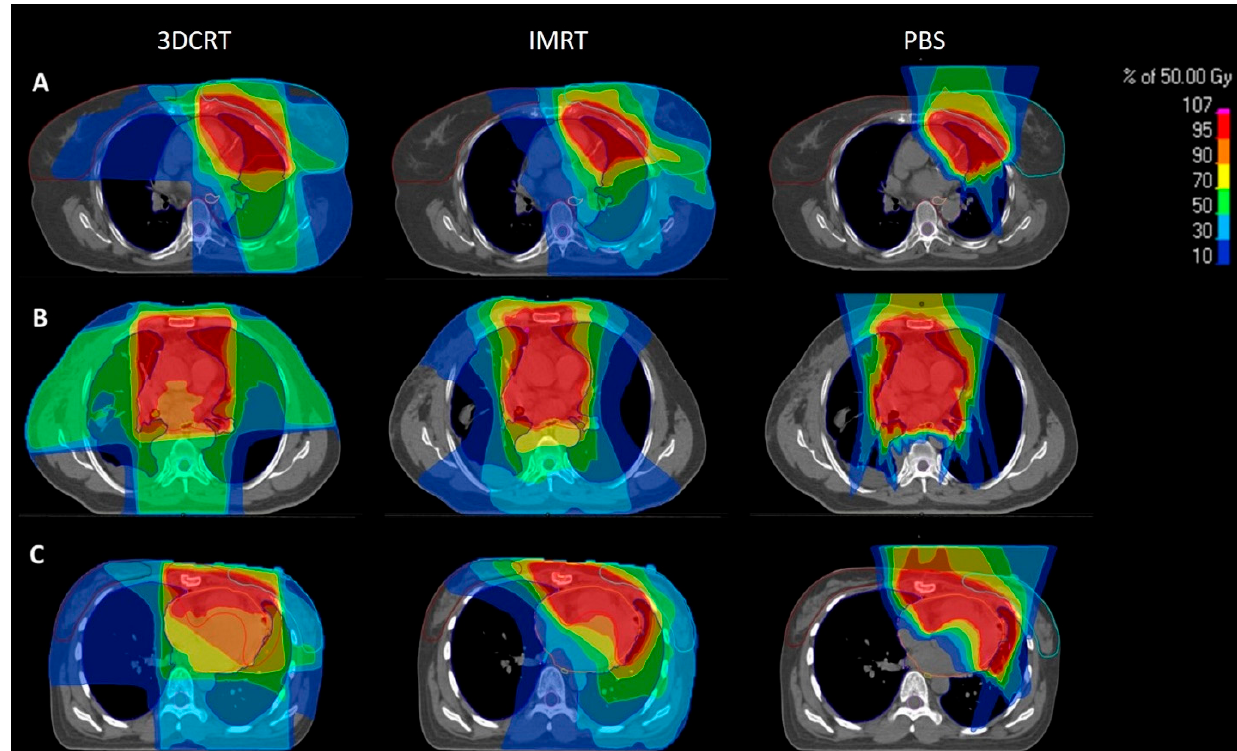
Figure 3. Three representative patients ( A – C ) with their comparative 3DCRT (first column), IMRT (second column), and PBS (third column) plans with color wash dose distribution. Compared to both the 3DCRT and IMRT plans, PBS plans enable dramatic reductions in integral dose exposure to adjacent OARs. 3DCRT: X-ray based 3D conformal radiotherapy, IMRT: X-ray based intensity- modulated radiotherapy, PBS: and active pencil beam scanned proton therapy.